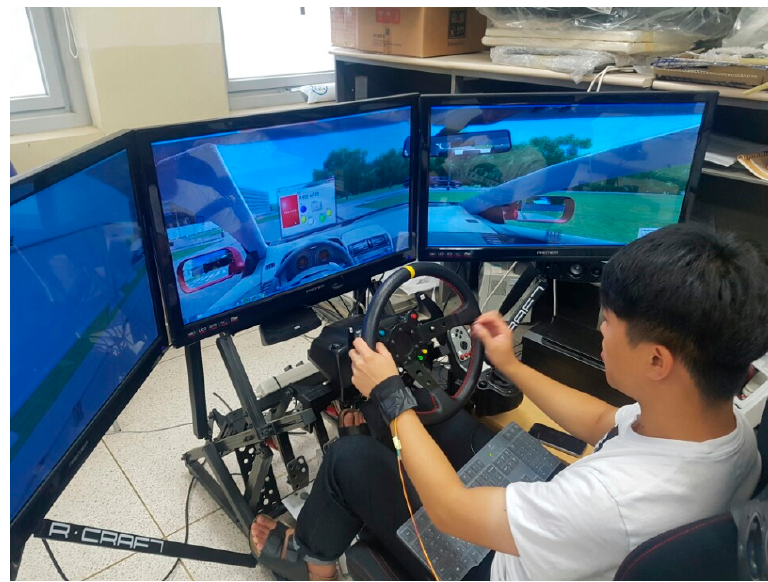
Figure 2. Experimental environment.